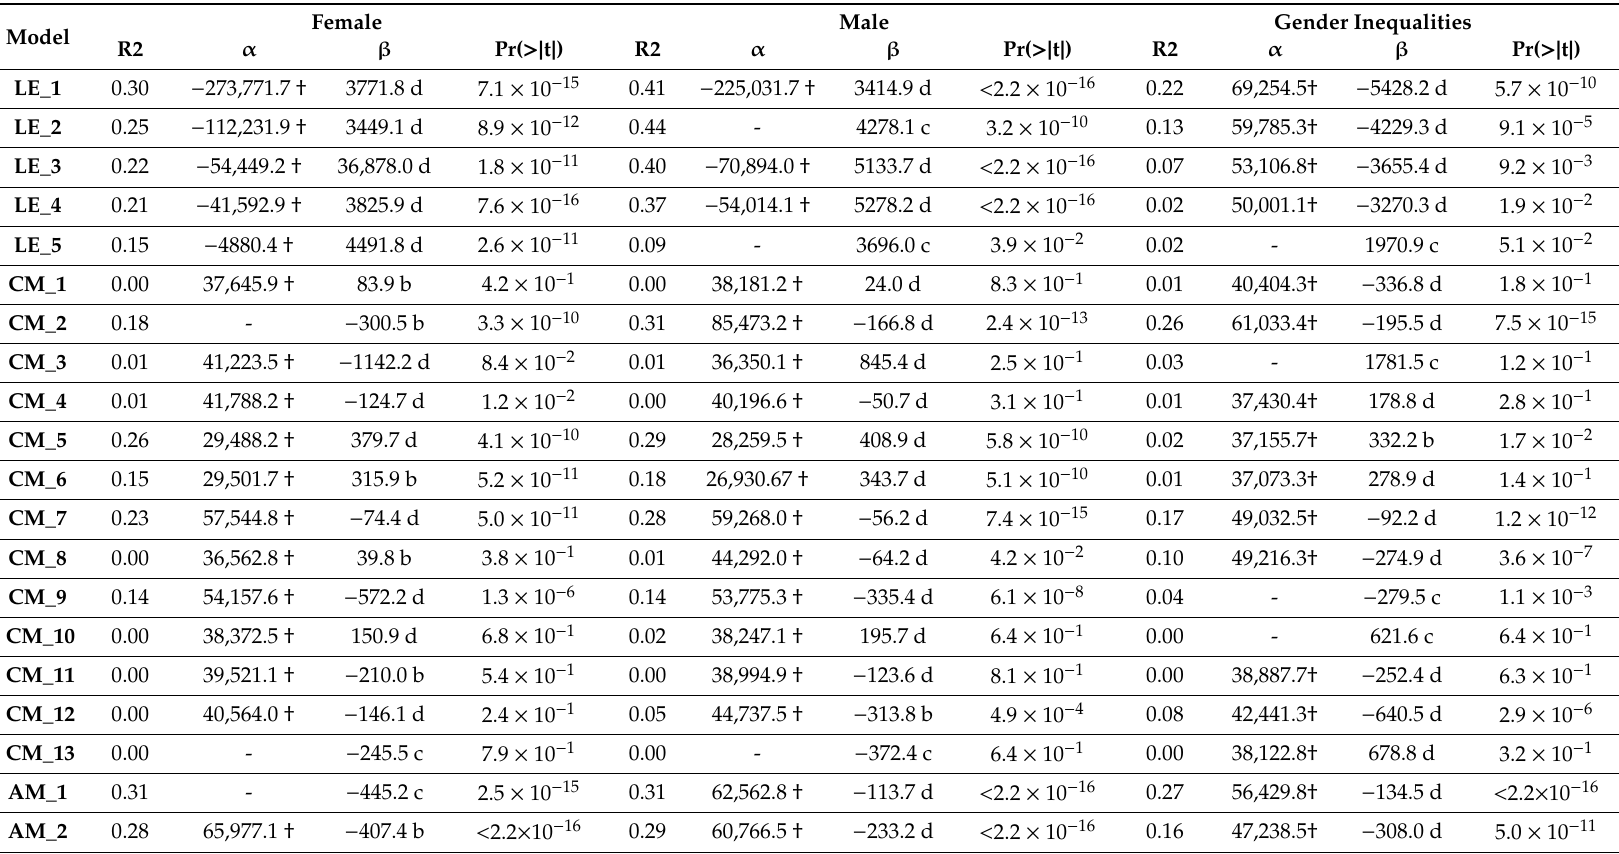
Table 8. Regression analysis output—a univariate